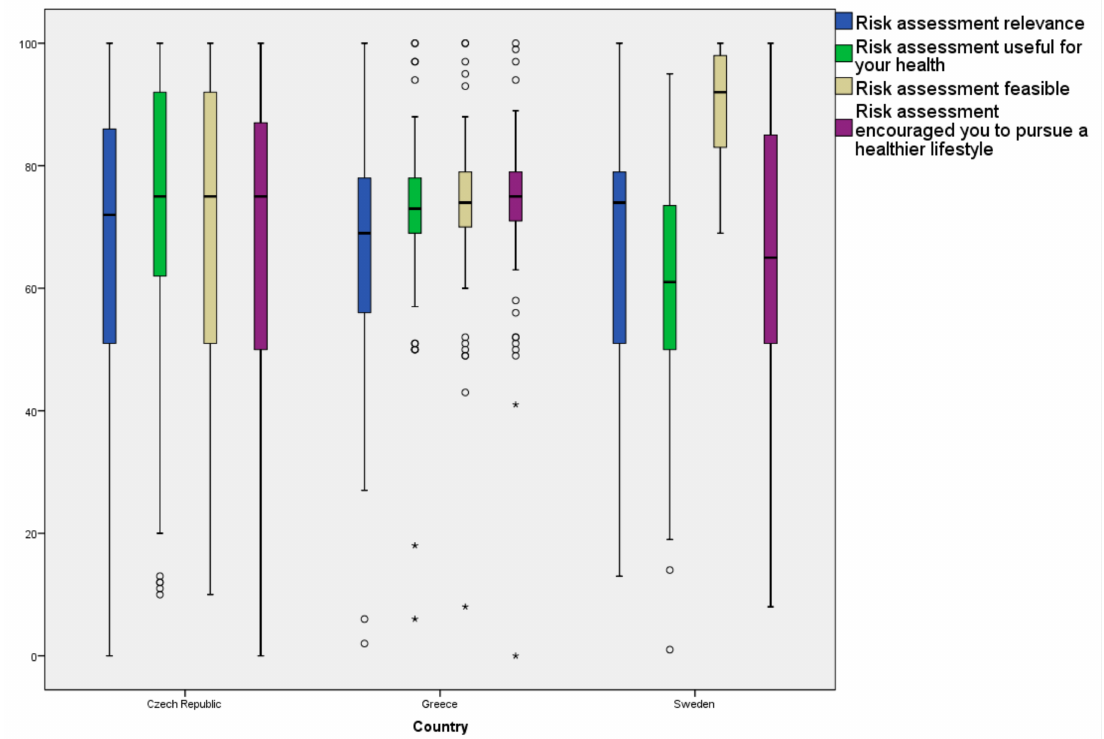
Figure 2. Participants’ evaluation of the risk assessment intervention. (Participants from Denmark and the Netherlands did not answer evaluation questions, despite their invitation to do